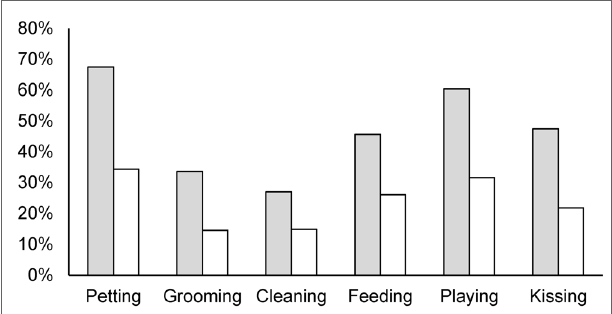
FigUre 1 | Proportion of respondents having different types of dog and cat contact in the month prior to the study. Gray bars are for dog contact and white bars are for cat contact.